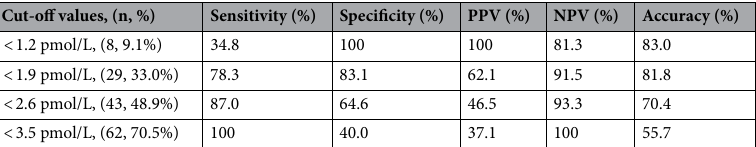
Table 2. Diagnostic performance of 3-month postoperative copeptin levels for central diabetes insipidus at postoperative visit. Data in the Cut-off values column were represented as the cut-off of postoperative copeptin levels, the number and proportion of indicated patients. PPV, Positive predictive value; NPV, Negative predictive value.